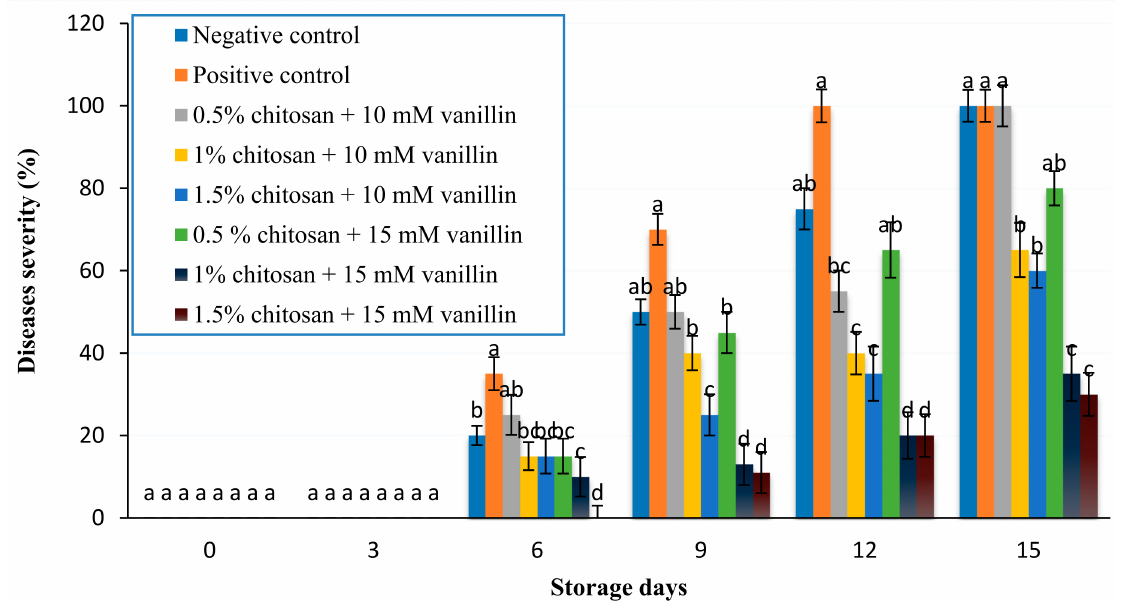
Figure 4. Effects of coating treatment on disease severity of Fusarium oxysporum in tomato fruit stored for 15 days at 26 ± 2 ◦ C and 60 ± 5% relative humidity. Mean values in a column followed by different letters for each storage day differed significantly by LSD at p ≤ 0.05. Vertical bars indicate standard error of means. Prior to analysis, the data were square root transformed, while non-transformed means are shown ( n = 24). Table 3. Pearson’s correlation coefficients for disease incidence and severity of Fusarium oxysporum